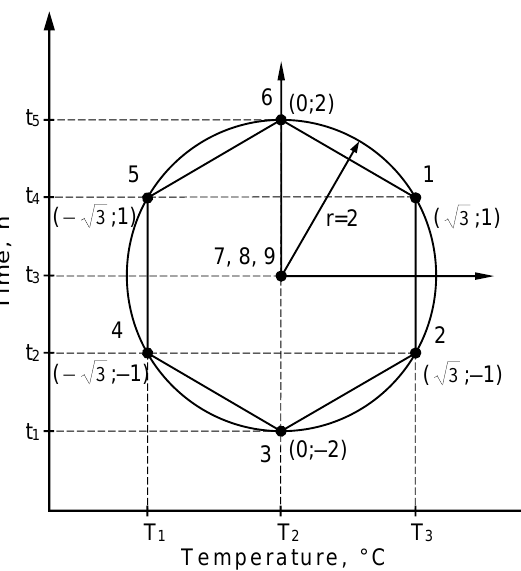
Figure 1. Diagram of planning the conditions of the nitriding process.